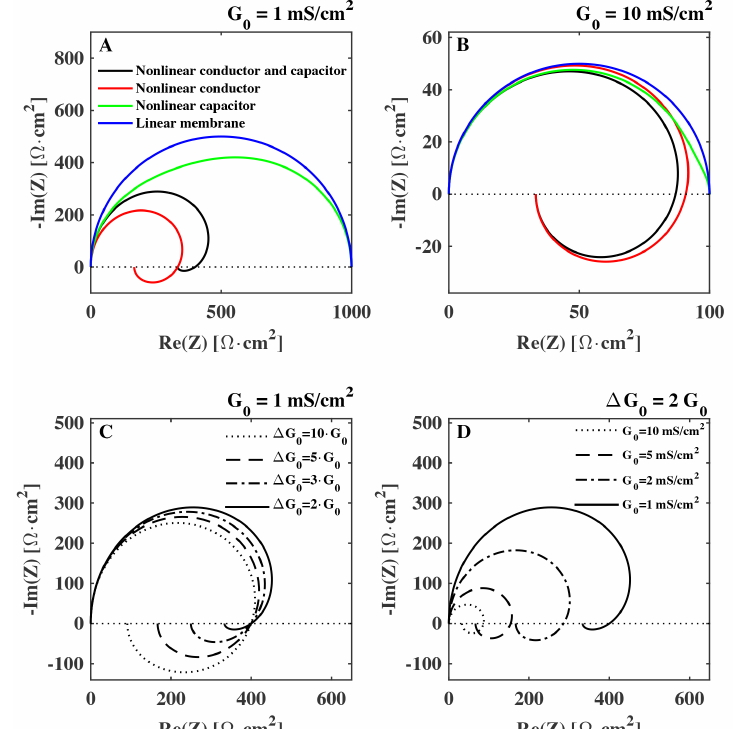
Figure 3. Calculated Nyquist plot of the impedance of a biological membrane = 0 (Equation (18)) shown for different degrees of nonlinearity: ( A )–( B ): blue : ∆ G 0 = 0 , green , ∆ G = 0 and ∆ C = 0 . 5 · C = 2 · G and ∆ C , red , ∆ G and 0 0 0 0 0 0 ∆ C = 0 , black , ∆ G = 2 · G = 0 . 5 · C and ∆ C . Membrane background 0 0 0 0 0 = 1 mS/cm 2 [1,9] ( A ), G = 10 mS/cm 2 ( B ). Membrane capacitance conductance: G 0 0 = 1 µF/cm 2 and the characteristic relaxation time is τ = 1 ms. ( C ): different values is C 0 of ∆ G . ( D ): different values of membrane conductance G 0 0